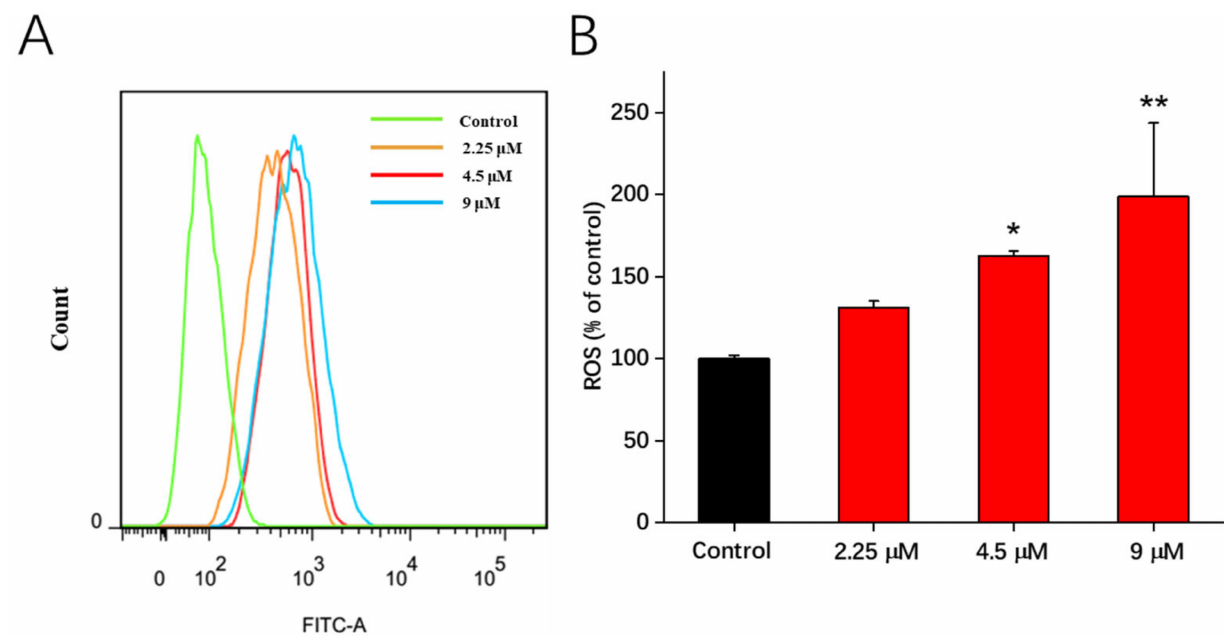
Figure 3. Effects of compound 1b on ROS generation in A549 cells. Cells were treated with compound 1b at the tested concentrations for 48 h. ( A ) ROS production in A549 cells was measured via flow cytometric analysis using DCFH-DA staining. ( B ) Related histograms for ROS levels are presented as the means ± SD ( n = 3). * p < 0.05, ** p < 0.01 vs. the control group.